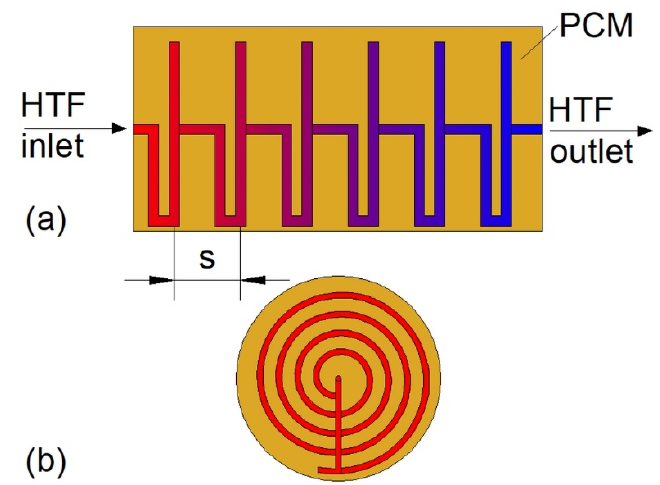
Figure 4. The new type of helical-coil heat exchanger (HX): ( a ) Side view, ( b ) front view [72]. s—spacing between flat spiral tubes.